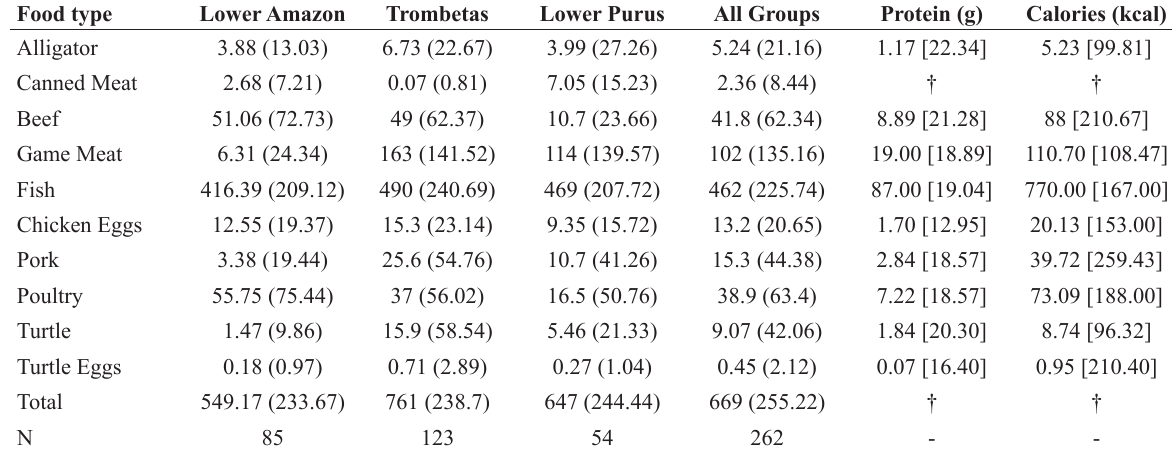
Mean rate (g.person -1 .day -1 ) and standard deviation (parentheses) of the consumption of different animal food items by the families of the three study areas (Amazon, Trombetas, and Purus). The mean protein (g) and calorie content are also given, with rates per 100 g shown in brackets.